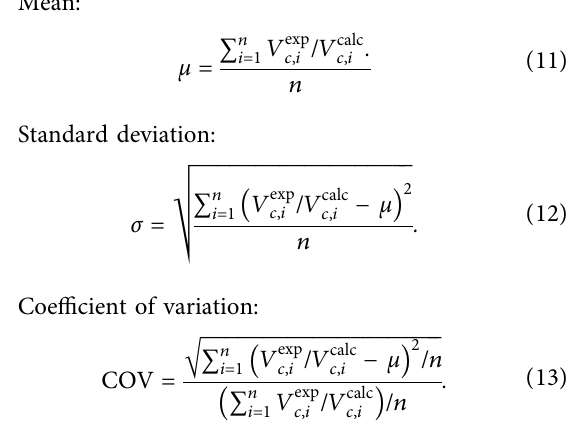
Figure 4: Histogram of the predictions of the proposed model.